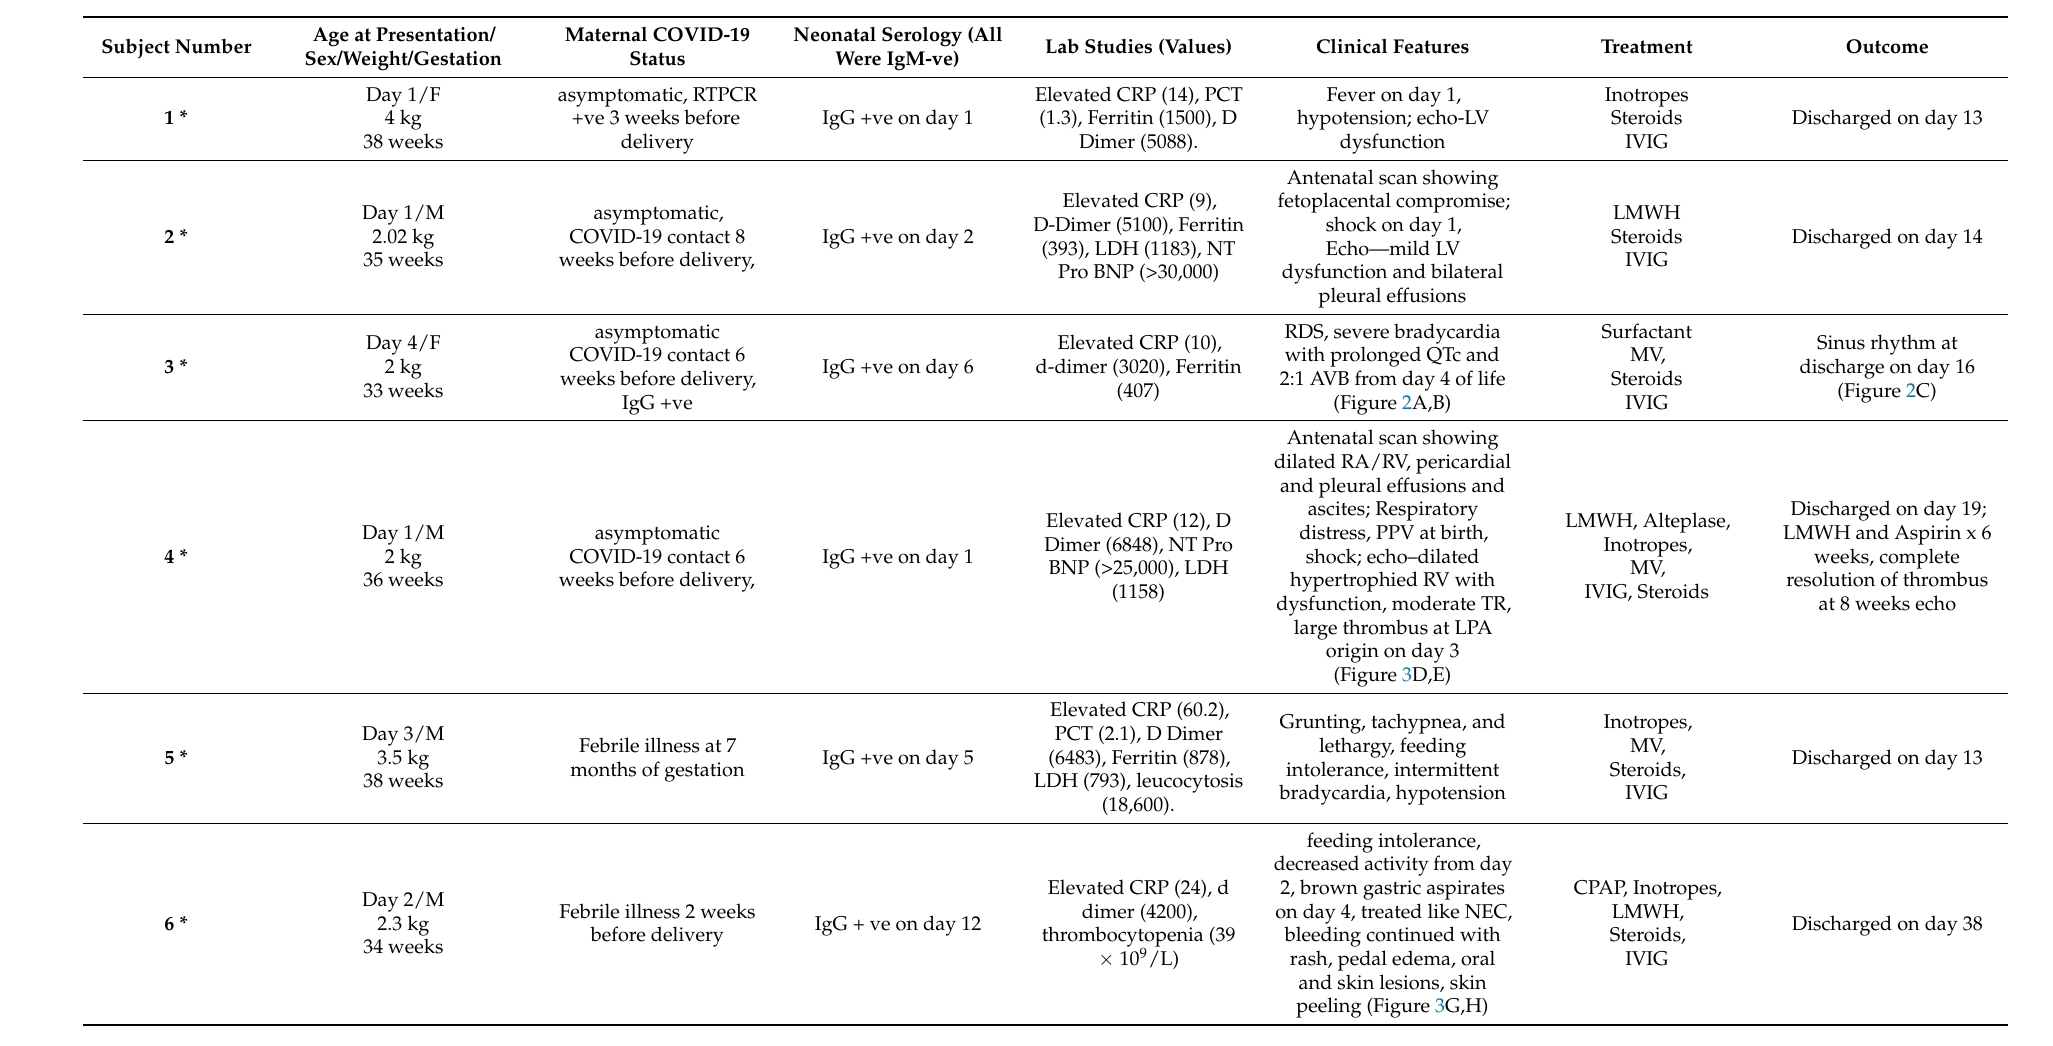
Table 3. Clinical features, treatments, and outcomes of suspected patients with Neonatal Inflammatory Multisystem Syndrome (MIS-C) associated with SARS-CoV-2